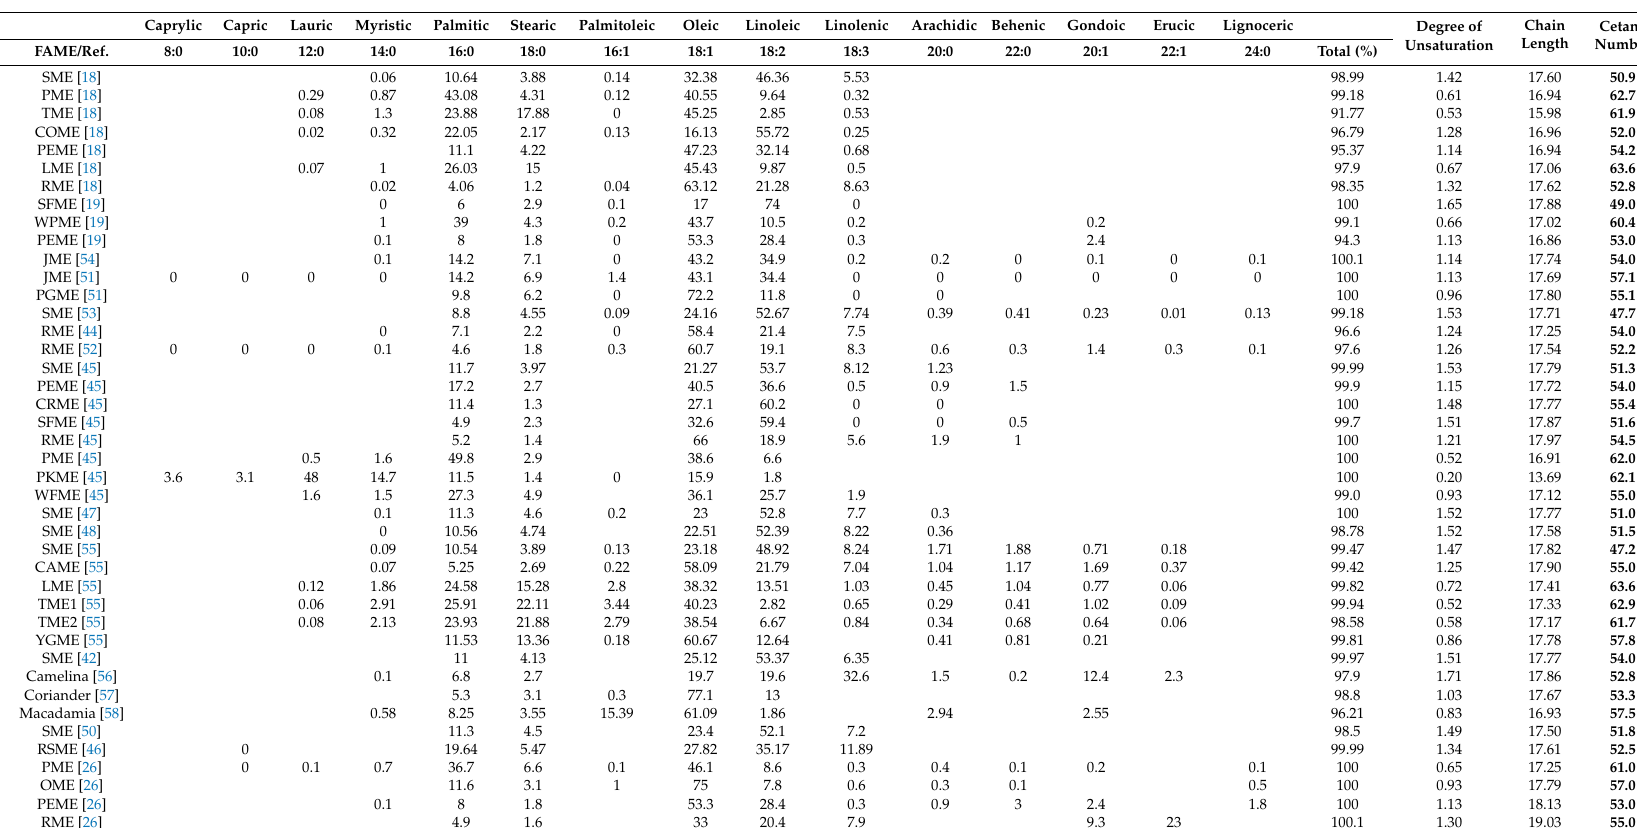
Table 4. Experimental data for the evaluation of all models’ predictive capability (fatty acid compositions and CNs have been reproduced with the accuracy provided in the original